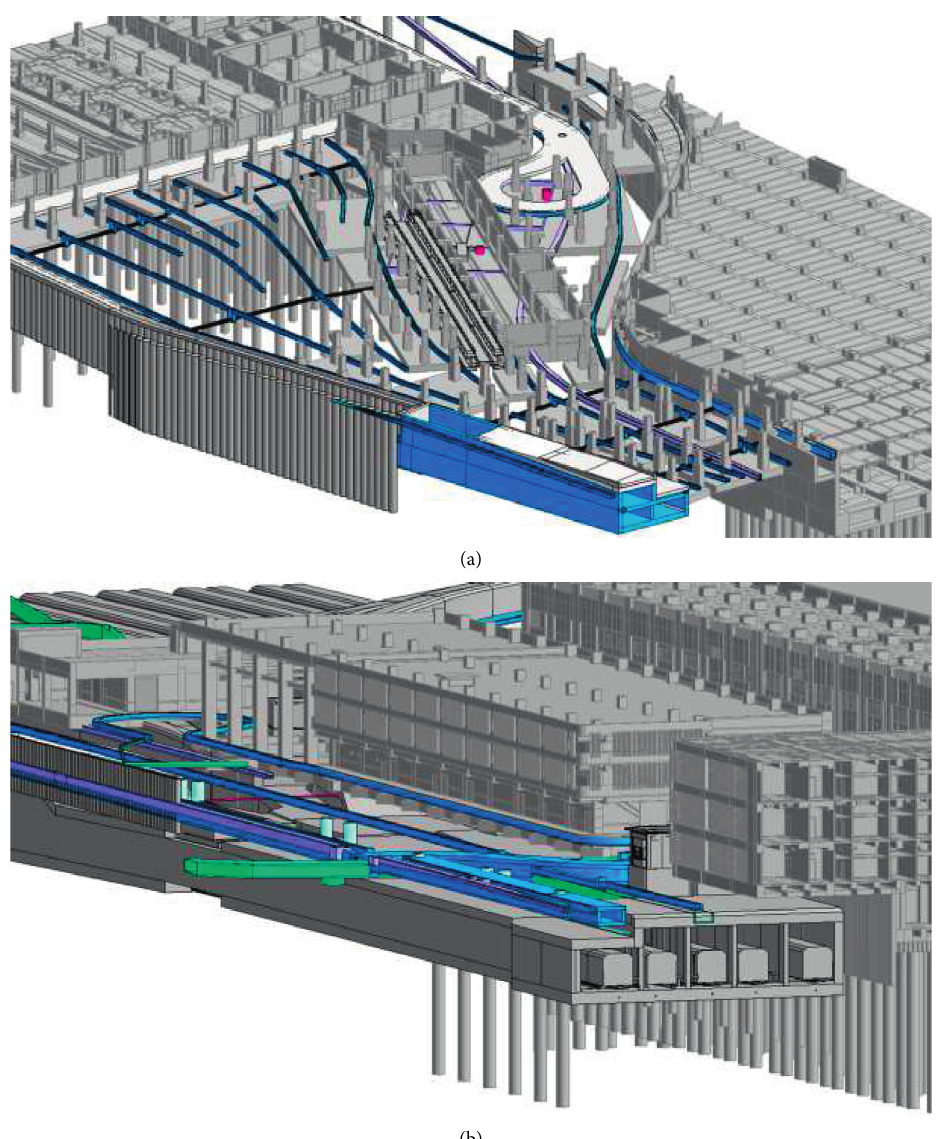
Figure 7: The integrated MRT BIM model in the case study. (a) The integrated BIM model for underground pipelines and depot building. (b) The integrated BIM model for the MRT tunnel and depot